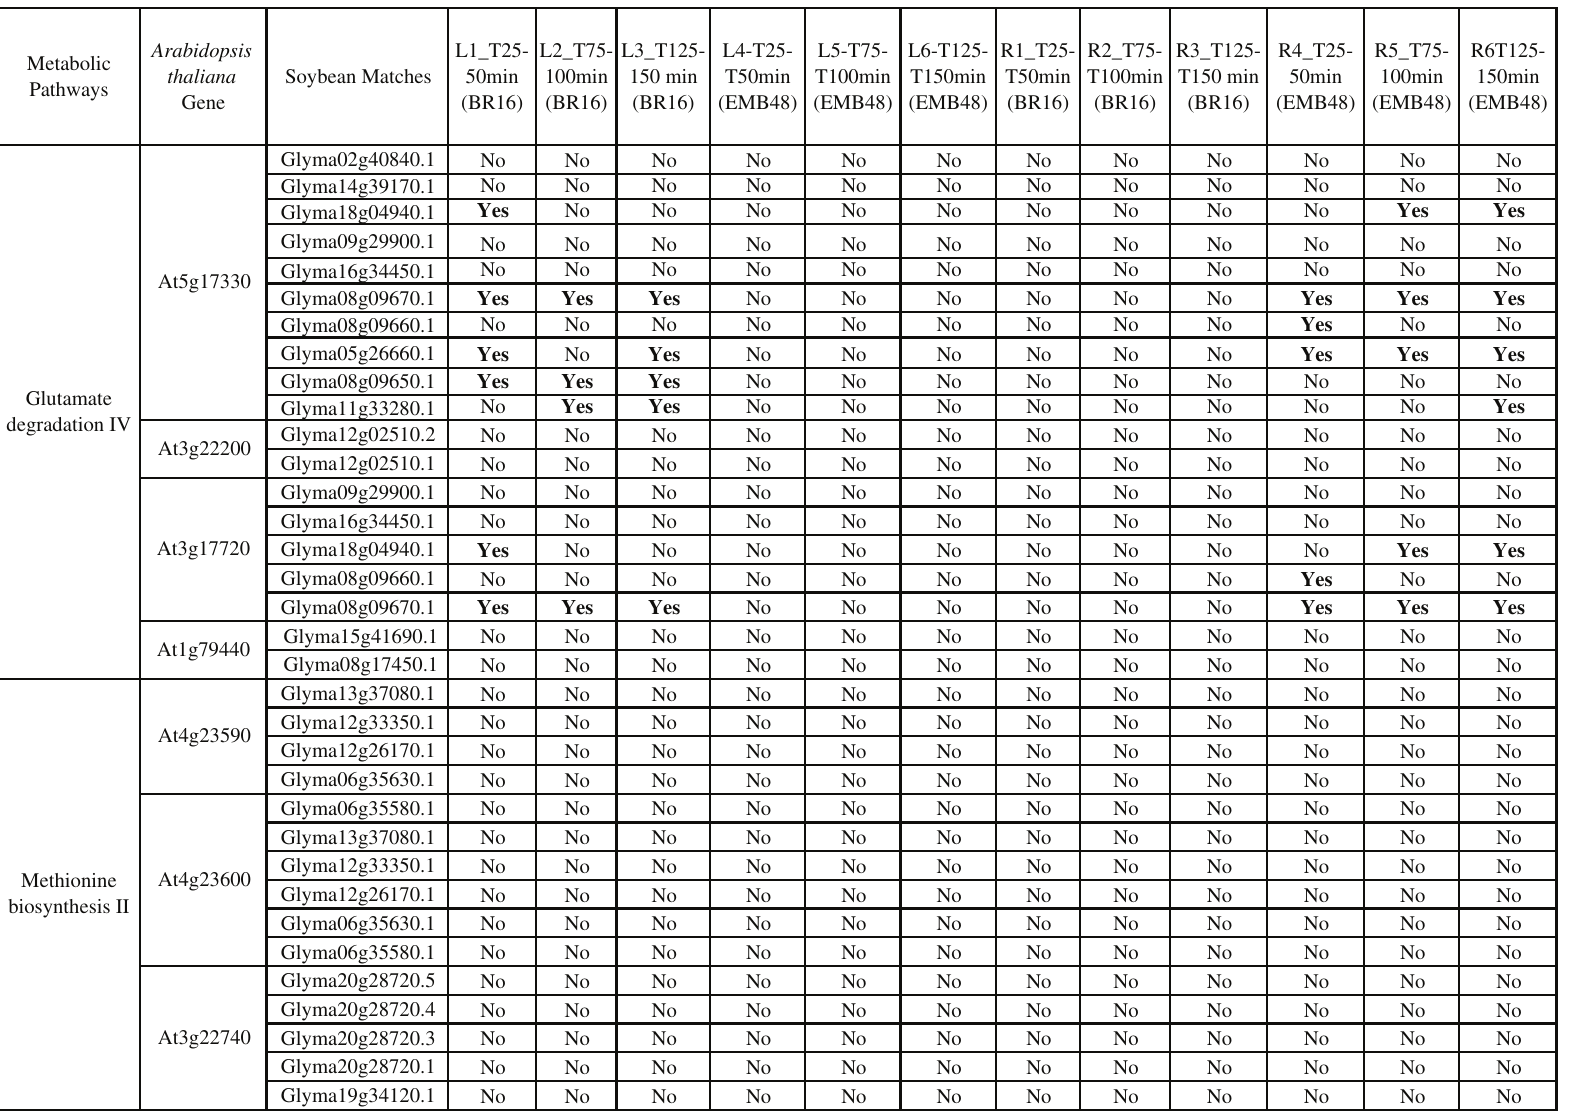
Table S2 - Prevalence of soybean matches regarding different metabolic pathways respon